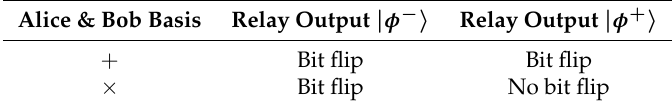
Table 1. Alice or Bob flip their key based on the outcomes of measurement and announced prepared basis [19].